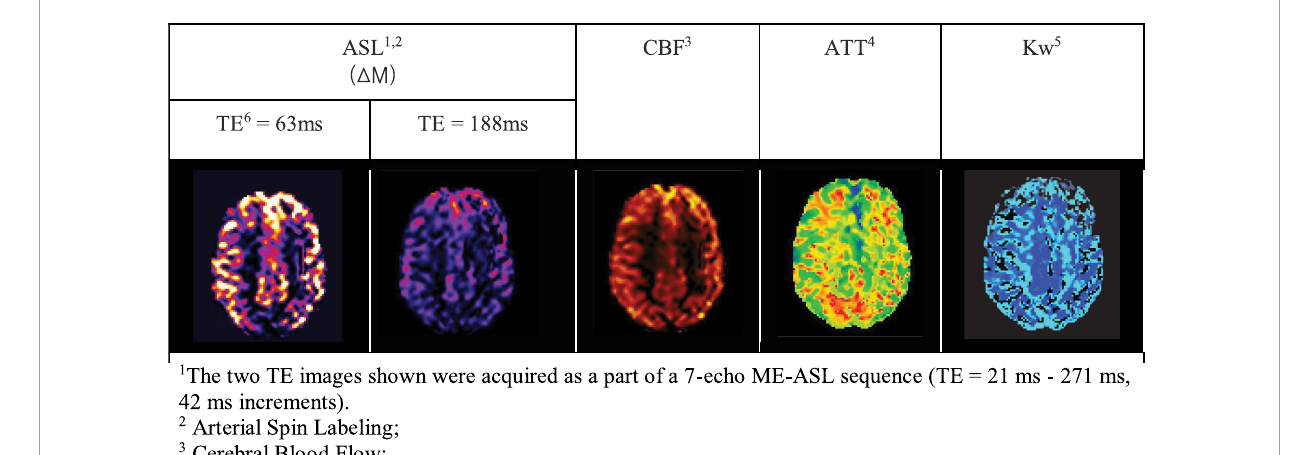
FIGURE6 Examples of ME-ASL perfusion-weighted MRI images in a cognitively normal, 70-year-old man (Manson et al., 2020).